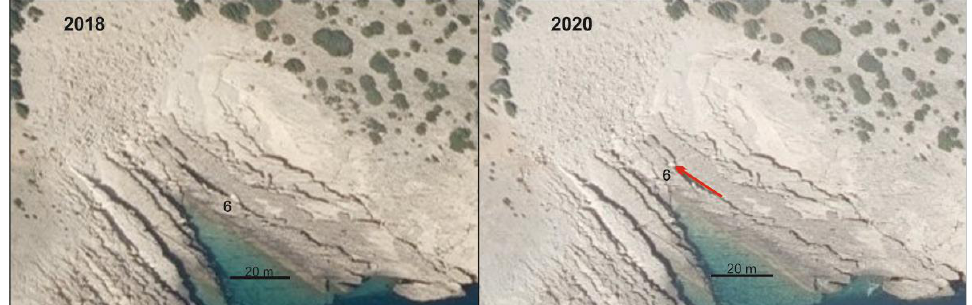
Figure 6. Low-resolution orthophoto images (https://geoportal.dgu.hr/ accessed on 8 January 2022) of the Mana coarse-clast deposit and the boulder in the front (MB-6) that were displaced (red arrow) between 2018 and 2020.